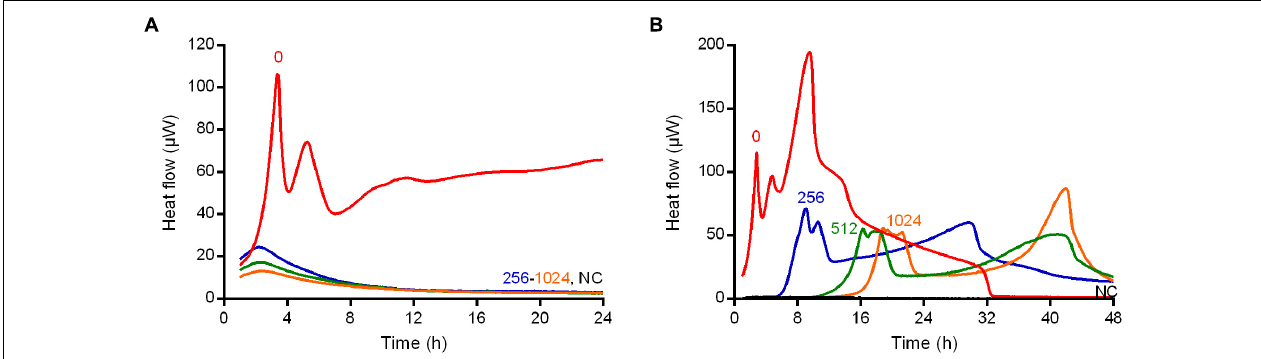
FIGURE 5 | Isothermal microcalorimetry evaluation of anti-biofilm activity of vancomycin against biofilm MRSA in real-time (A) during and (B) after 24 h-treatment. Numbers represent antibiotic concentrations ( µ g/ml). A negative control has been used to confirm medium sterility (NC). Representative data of replicated experiments are